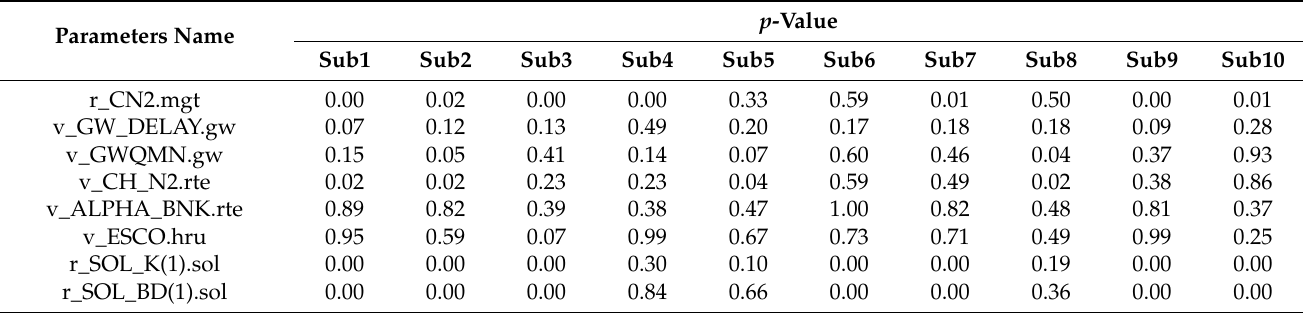
Table 5. Sensitivity analysis of SWAT model parameters in different subbasins for the calibration